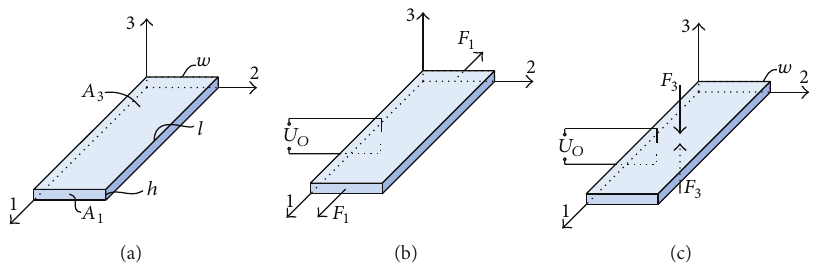
Figure 1: (a) A PVDF energy harvester unit, (b) 31-mode, and (c)